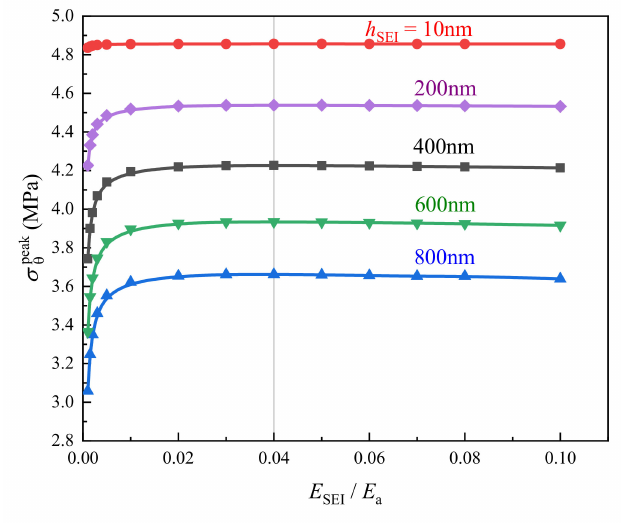
Figure 7. E ff ects of modulus ( E SEI ) and thickness of SEI ( h SEI ) on peak hoop stress ( σ peak θ ) in